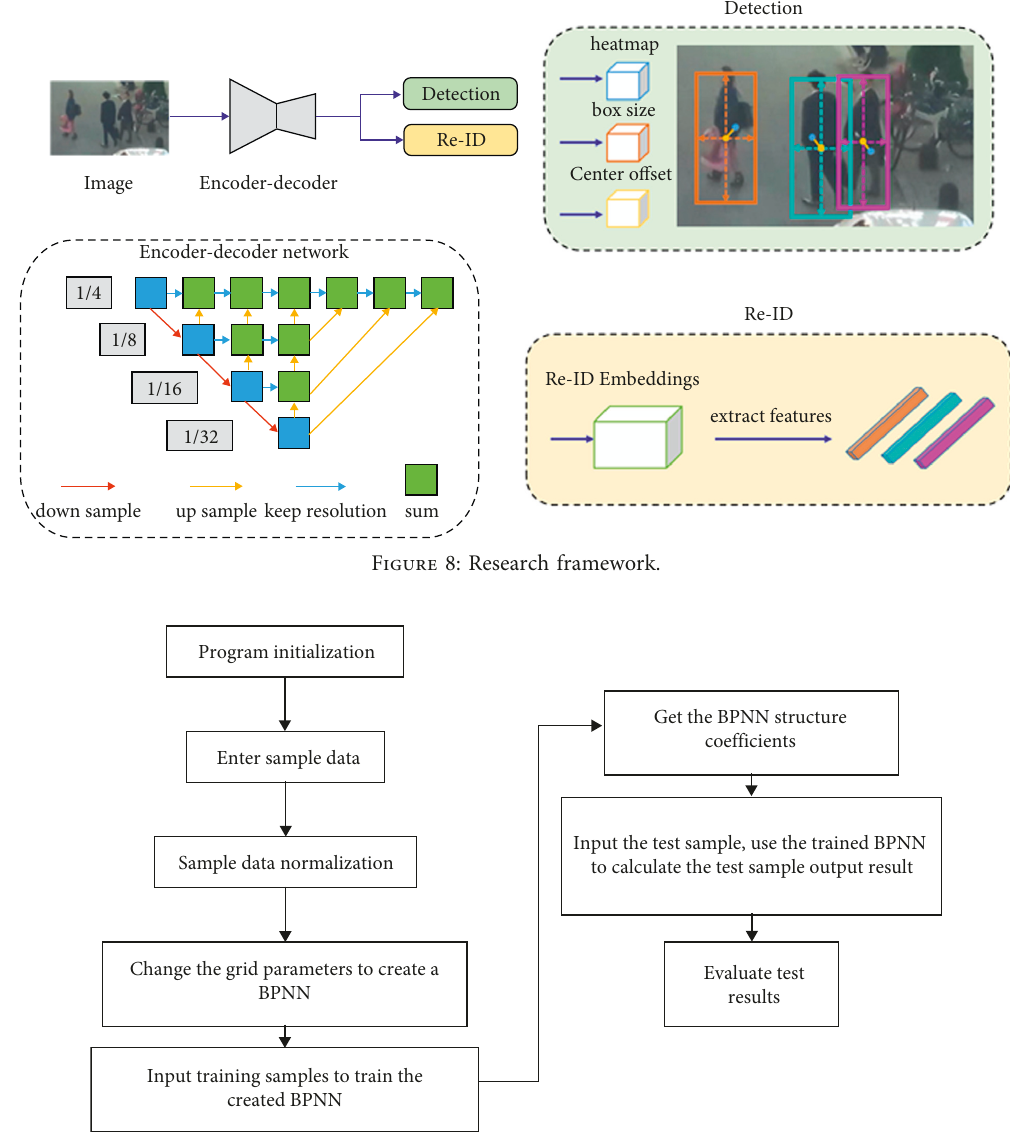
Figure 9: Experimental procedure of neural network grouping.